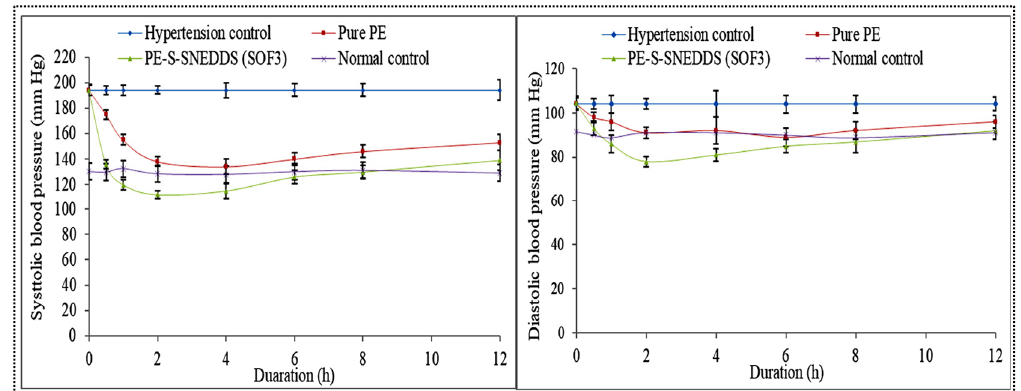
Figure 10. Antihypertensive potential (left) Systolic BP and (right) diastolic BP of hypertension group, pure PE, S-PE-SNEDDS (SOF3), and normal group rats. Values are given as mean ± SD ( n = 6).